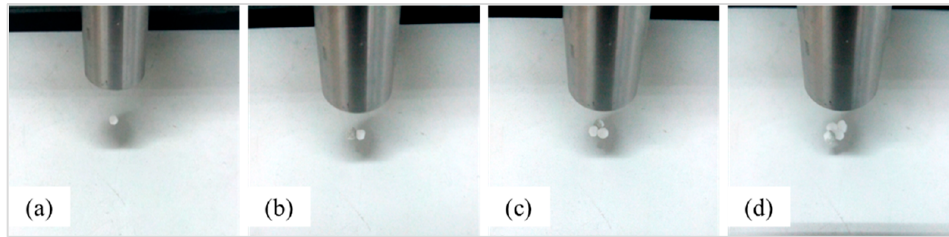
Figure 9. The suspension state of different numbers of particles at the node position: ( a – d ) Diagram of different numbers of particles. of different numbers of